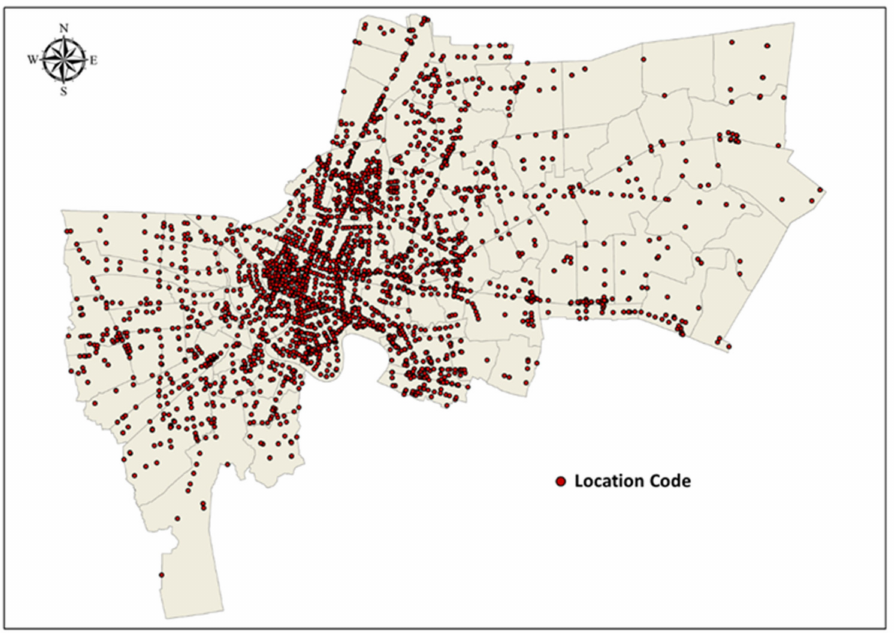
Figure 5. iTIC location codes in